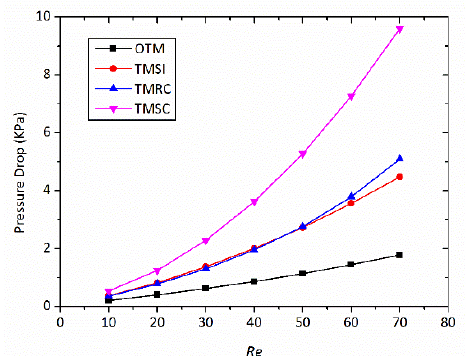
Figure 12. Pressure drop for different micromixer at different Reynolds numbers.